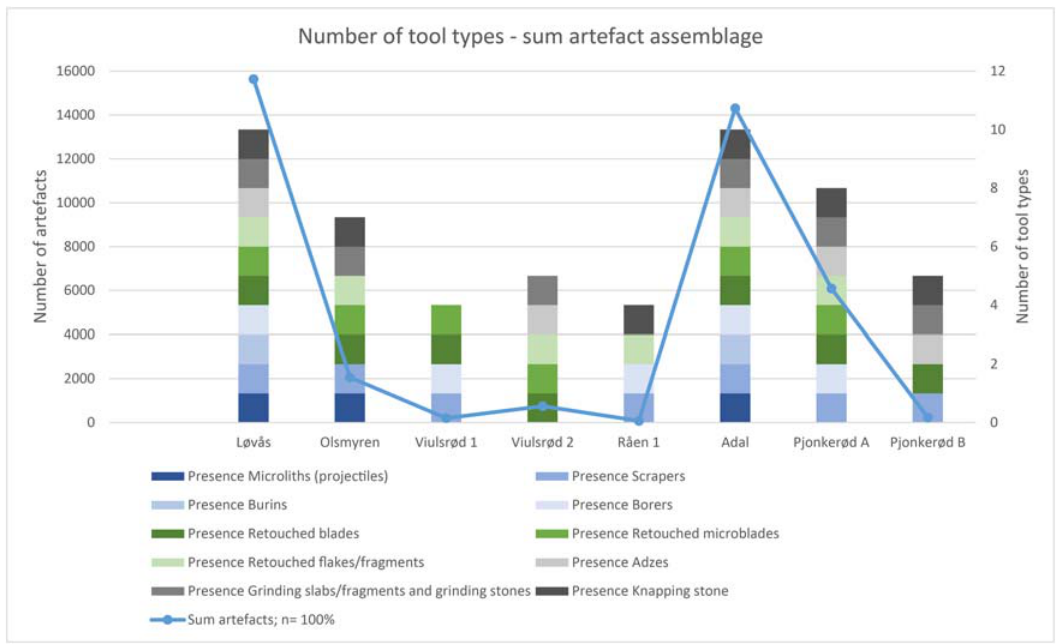
Figure 9: Diversity in the presence of tool types in eight assemblages from Horten Municipality, northern Vestfold. Number of tool types partly co - varies with the size of the complete assemblage, although not completely. For data see Supplementary File